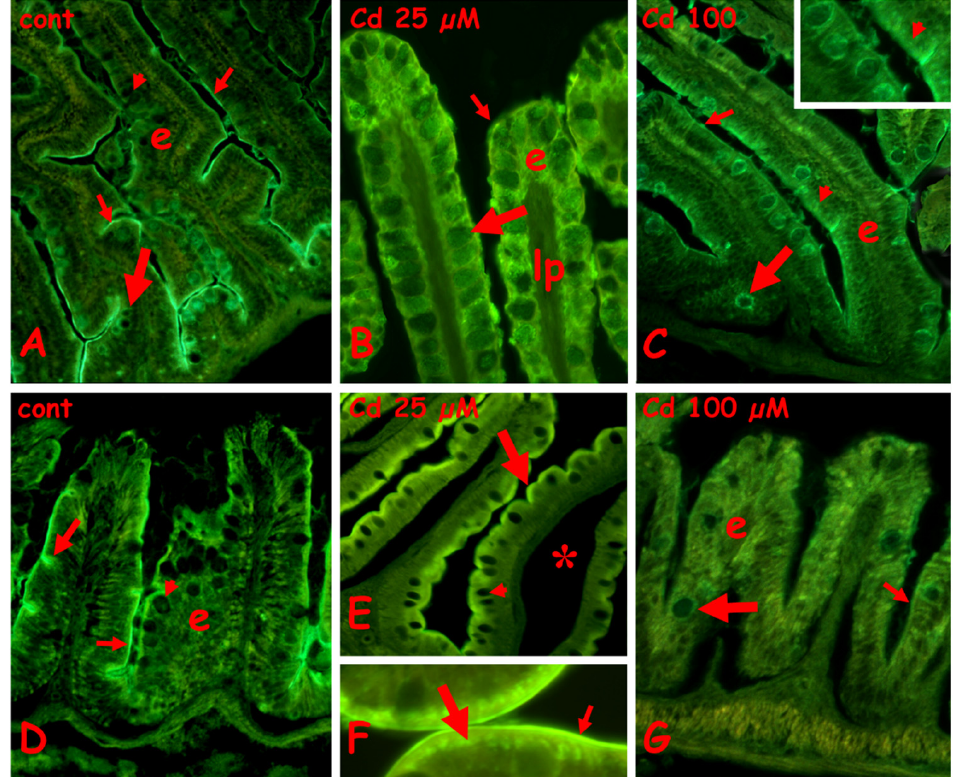
Figure 6. Effects of cadmium exposure on gut cells carbohydrate composition: staining for N-acetyl- galactosamine with fluorescent lectin RCA. Anterior ( A – C ) and mid ( D – F ) gut. ( A ) Villi with labeled brush border (small arrows) and cytoplasm of basal goblet cells (large arrow). The enterocytes (e) and the goblets cells located in the apical portion of villi (arrowhead) are unlabeled. ( B ) Diffuse labeling on enterocytes (e), brush border (small arrow), and goblet cells (large arrow). Unlabeled lamina propria (lp). ( C ) Labeled goblet cells cytoplasm (large arrow) and brush border (small arrow); enterocytes € show a moderate apical positivity (arrowhead and inset). ( D ) Labeled brush border (small arrow) and mucus vesicles in occasional goblet cells (large arrow); unlabeled enterocytes (e) and goblet cells (arrowhead). ( E , F ) Labeled apical cytoplasm of enterocytes (large arrow) and brush border (small arrow). Unlabeled goblet cells (arrowhead), seric infiltrate (*). ( F ) Detail of ( E ). ( G ) Unstained enterocytes (e), goblet cells (large arrow), and brush border (small arrow).